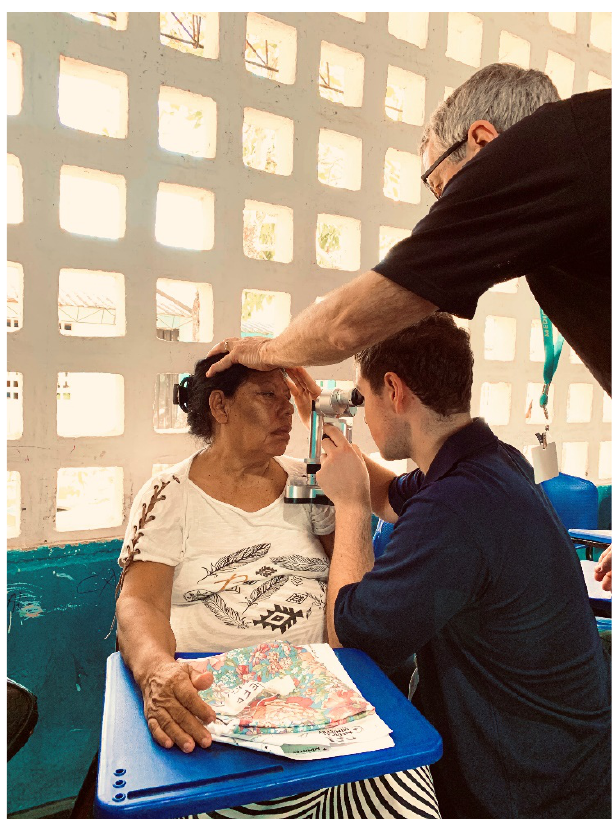
Figure 2 . Assisting with eye exams in Ciénaga de Oro,